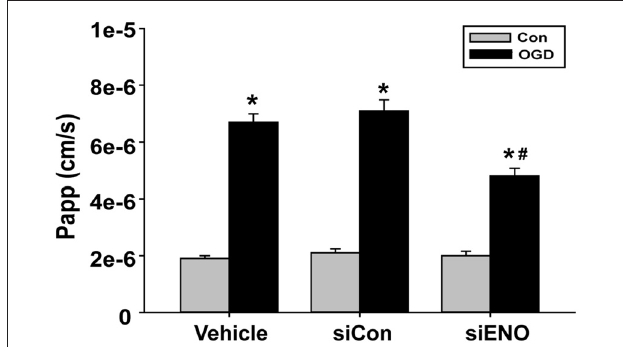
FIGURE 8 | Knockdown of ENOPH1 with siRNA reduces OGD induced blood brain barrier (BBB) disruption in vitro . The permeability of fluorescein isothiocyanate (FITC)-dextran across bEND3 monolayers was significantly increased after 6 h OGD. This was partially inhibited by pretreating cells with ENOPH1 siRNA. The permeability of the endothelial monolayer was assessed by calculating the transfer rate of FITC-dextran from the luminal compartment to the abluminal compartment, and was expressed as the apparent permeability coefficient (Papp, cm/s). ∗ P < 0.05 vs. Con, # P < 0.05 vs. siCon + OGD; n = 4. Papp [cm/s] = dQ/(dt ∗ A ∗ Co), dQ: the amount of FITC-dextran getting into the abluminal compartment; dt : duration of OGD treatment; dQ/dt : the rate of transfer (ng/s); A: surface area (cm 2 ); Co: the initial concentration in the luminal chamber (ng/cm 3